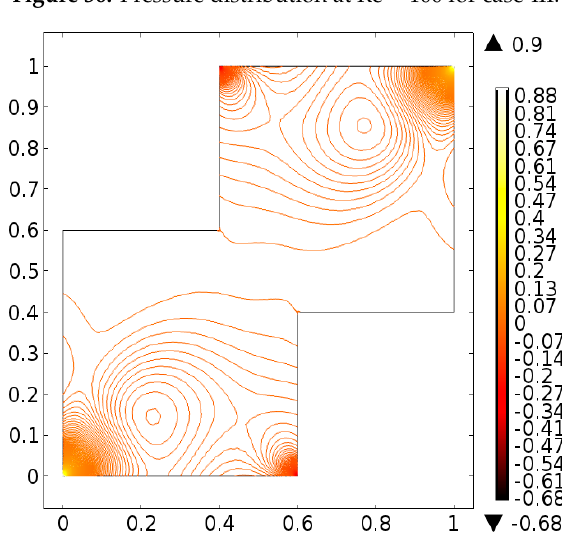
Figure 37. Pressure distribution at Re = 400 for case-III.